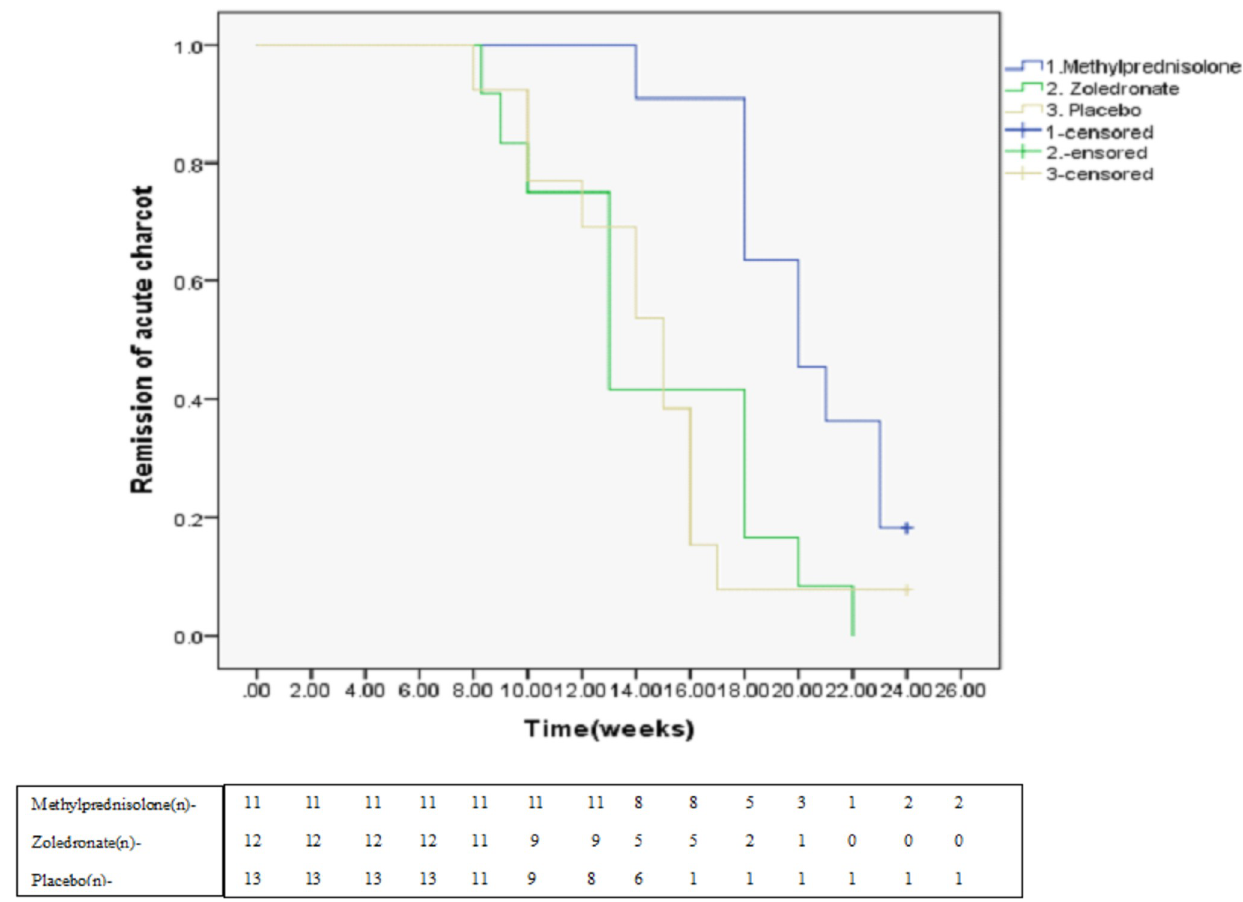
Fig 2. Kaplan-Meier curve for remission of active Charcot foot in the three groups.